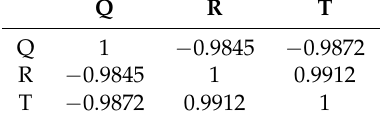
Table 3. Results of Pearson’s correlation coefficient between HIs. Q